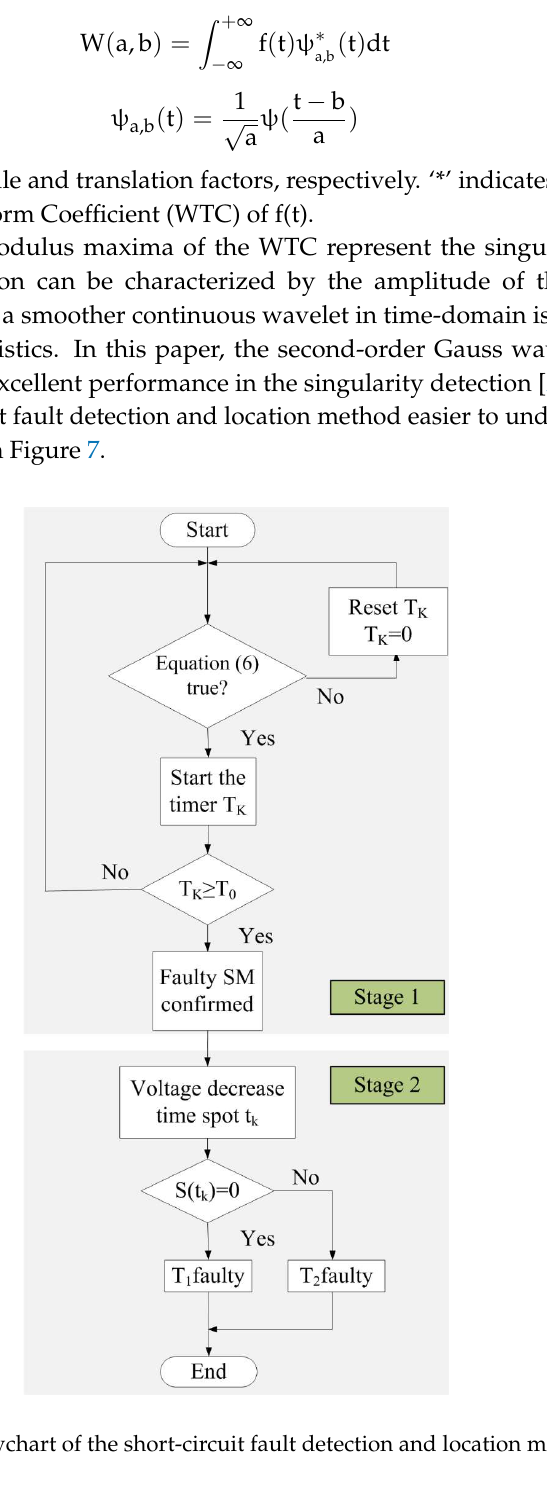
Figure 7. Flowchart of the short-circuit fault detection and location